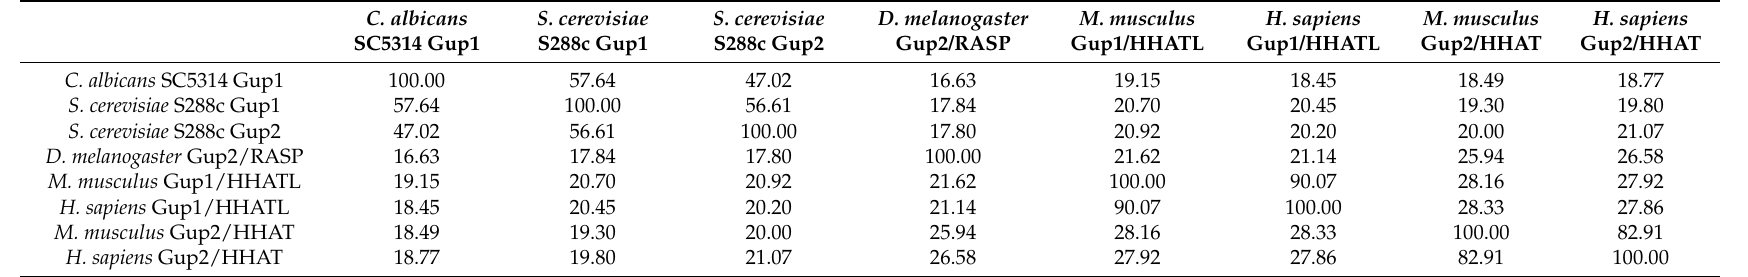
Table 4. Similarity matrix between the most studied GUP